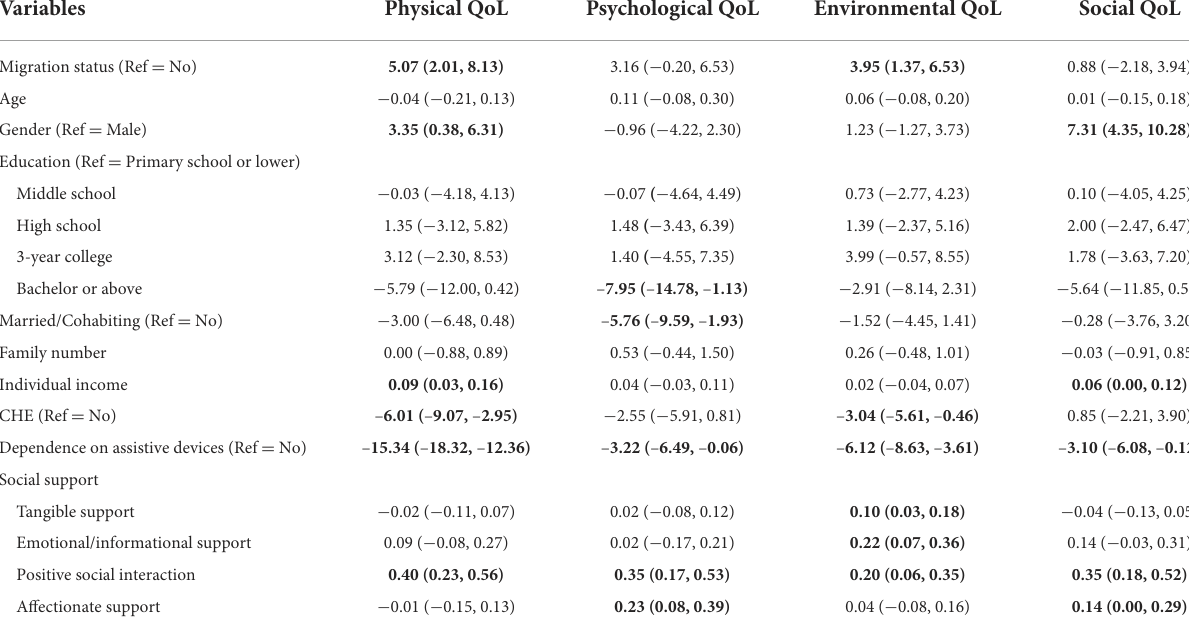
TABLE 3 Direct effects of migration on the four dimensions of QoL for rural adults with rare